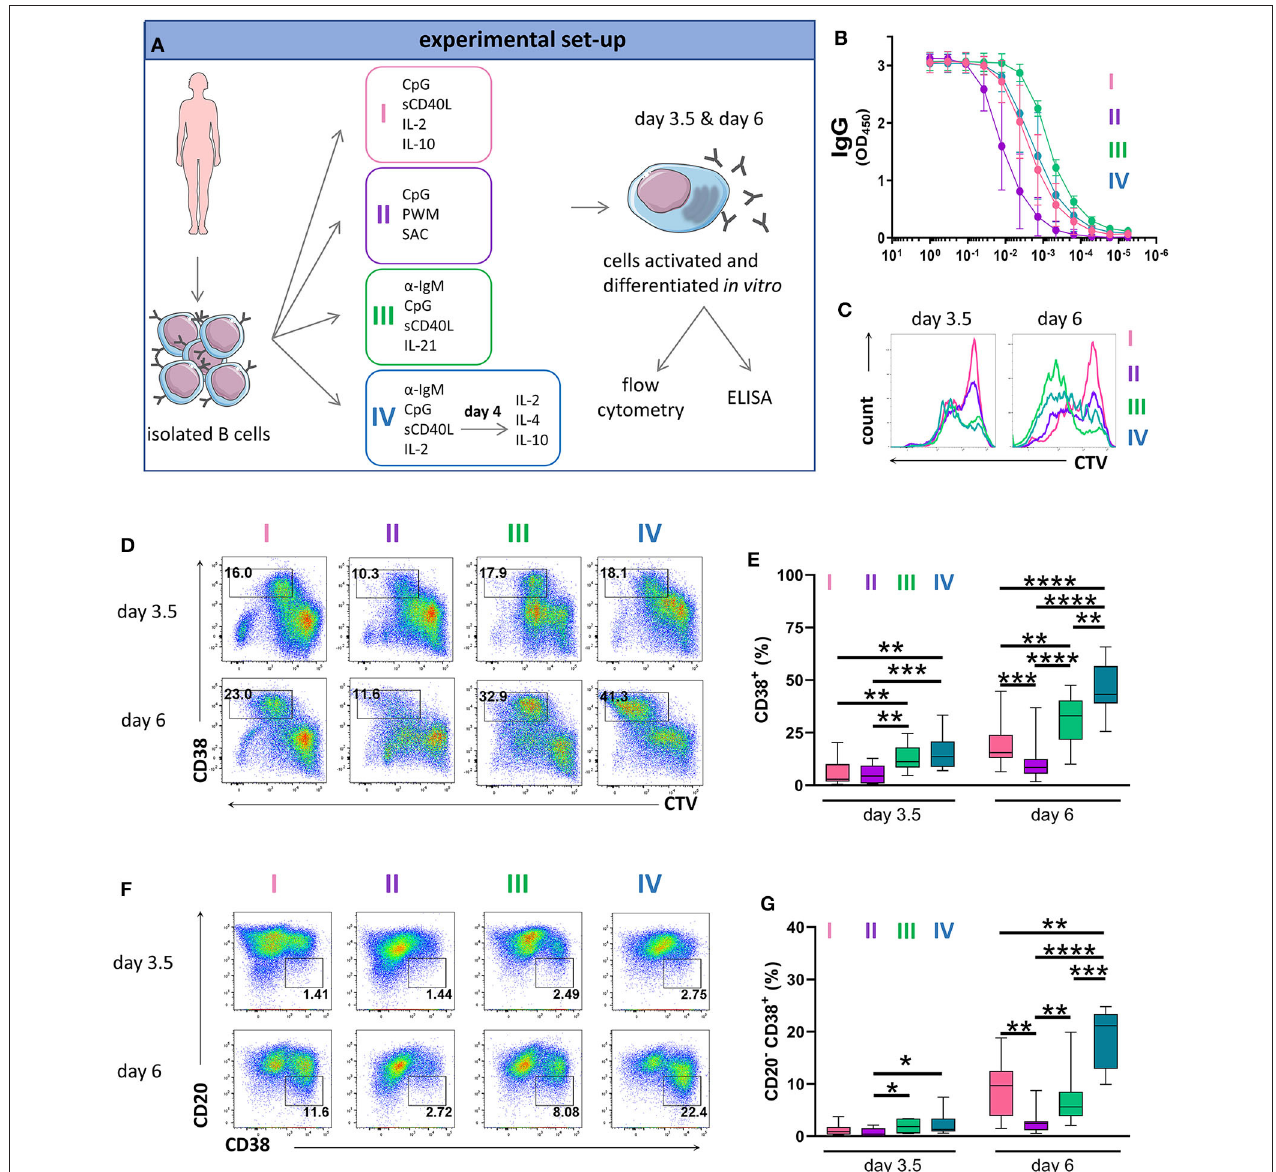
FIGURE 1 | Antibody production and phenotype of primary human B cells after in vitro stimulations and culturing. (A) Schematic representation of the experimental approach. Total human B cells were isolated from healthy donor blood, stimulated under the indicated conditions and analyzed at day 3.5 and day 6 by flow cytometry to evaluate PC generation. Cells were pre-gated on FSC-A/FSC-W to identify singlets and on FSC-A/SSC-A to identify lymphocytes. The supernatant was collected at day 6 to evaluate IgG production by ELISA. This overview was created using images from Servier Medical Art, which are licensed under a Creative Commons Attribution 3.0 Unported License (http://smart.servier.com). (B) Total IgG production from supernatant of cultured cells at day 6 was evaluated by ELISA. Each line and error bar indicate mean ± s.d. (C) Cells were labeled with CTV prior to stimulation. Representative histogram plots show an overlay of CTV dilution